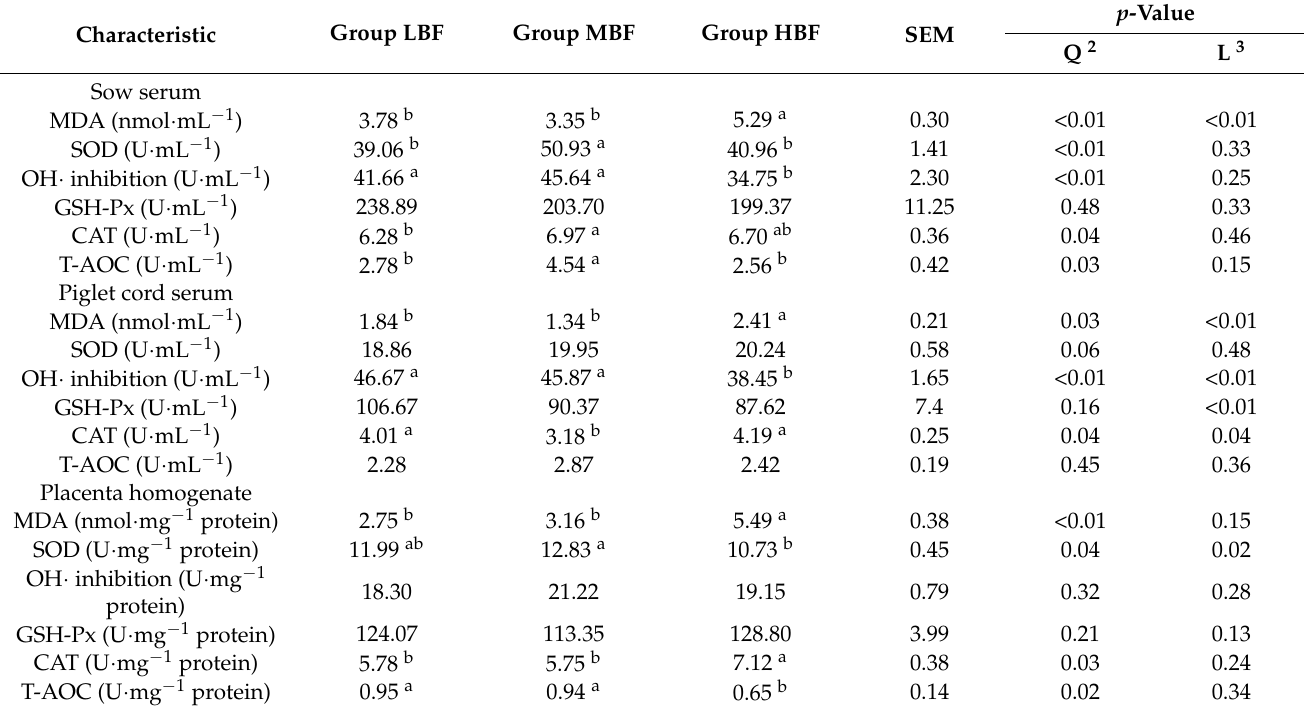
Table 3. Oxidant/antioxidant status in sow serum, piglet cord serum, and placenta homogenate 1 .